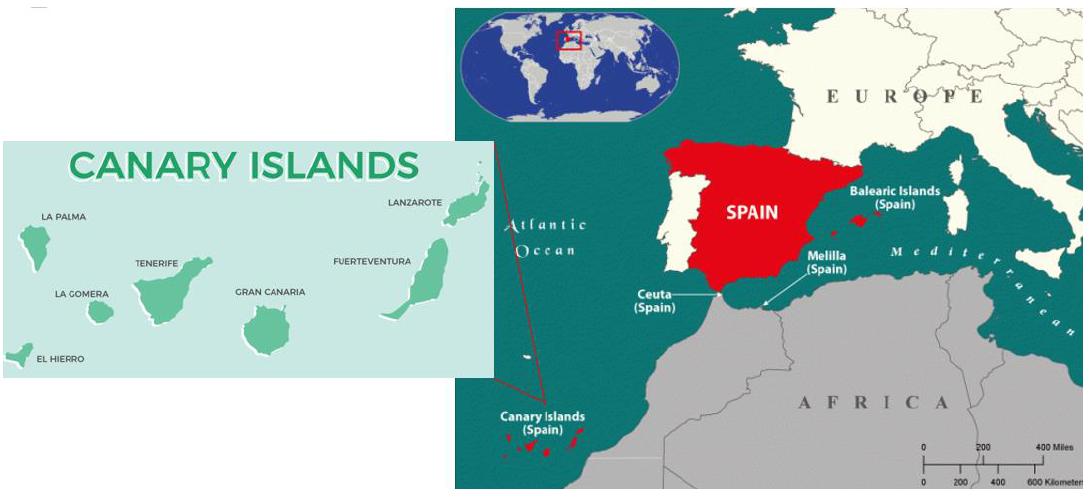
Figure 1 Methodology scheme.